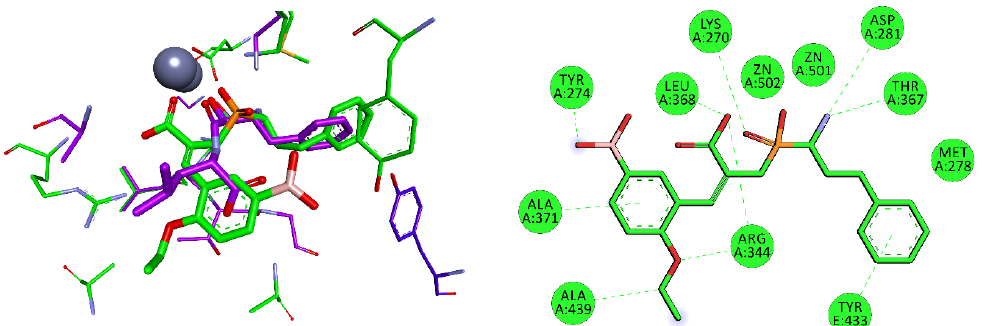
Figure 8. Modeled binding mode of a phosphinic dehydrodipeptide analog containing a 3-borono-6- ethoxyphenyl P1 ′ fragment in the active center of Helicobacter pylori aminopeptidase A/I (PDB: 4ZLA). The arrangement of the designed inhibitor was compared with that of bestatin, whose carbon atoms are colored in purple. Similar coloration was applied to amino acids interacting with the selected ligand. Carbon atoms of Tyr433 of another protein subunit are colored in dark blue. Amino acid residues of the inhibitor and enzyme are shown as sticks, while zinc ions are shown as gray spheres. Hydrogen bonds and nonpolar interactions are shown as thin dashed lines.